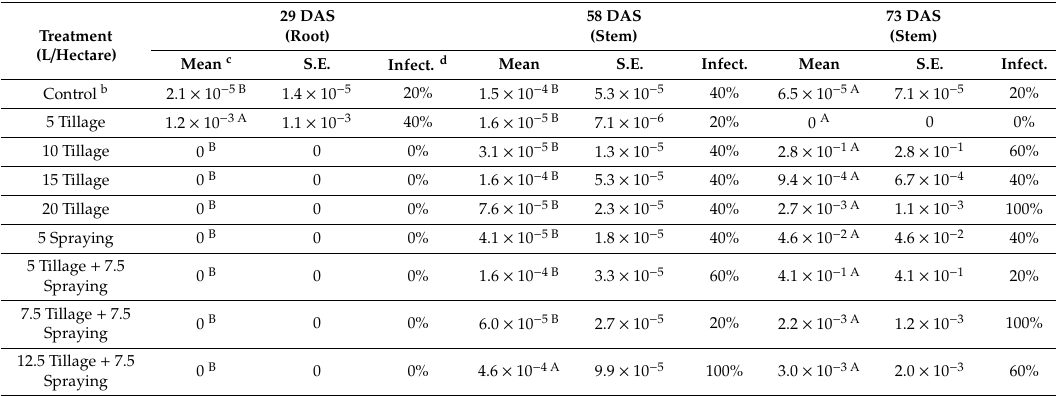
Table 6. qPCR diagnosis in the field (Neot Mordechai, spring 2018) a . 29 DAS Treatment (Root) (L / Hectare)